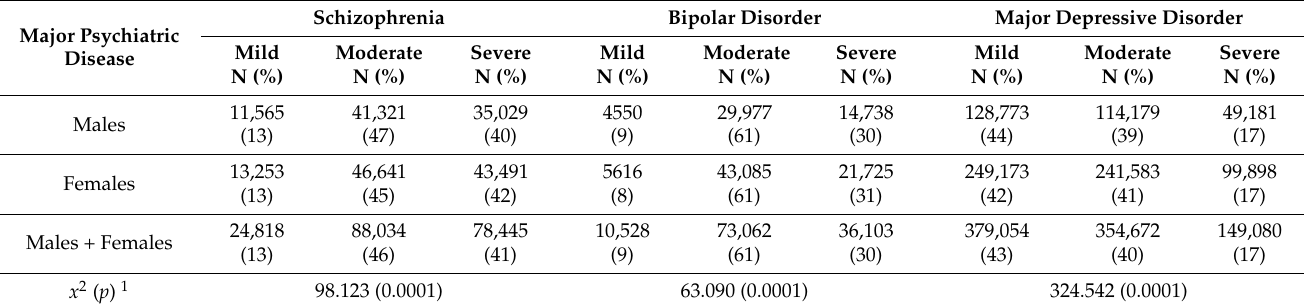
ICD-10 = International Classification of Disease, 10th edition. 1 Values are expressed as the chi square.